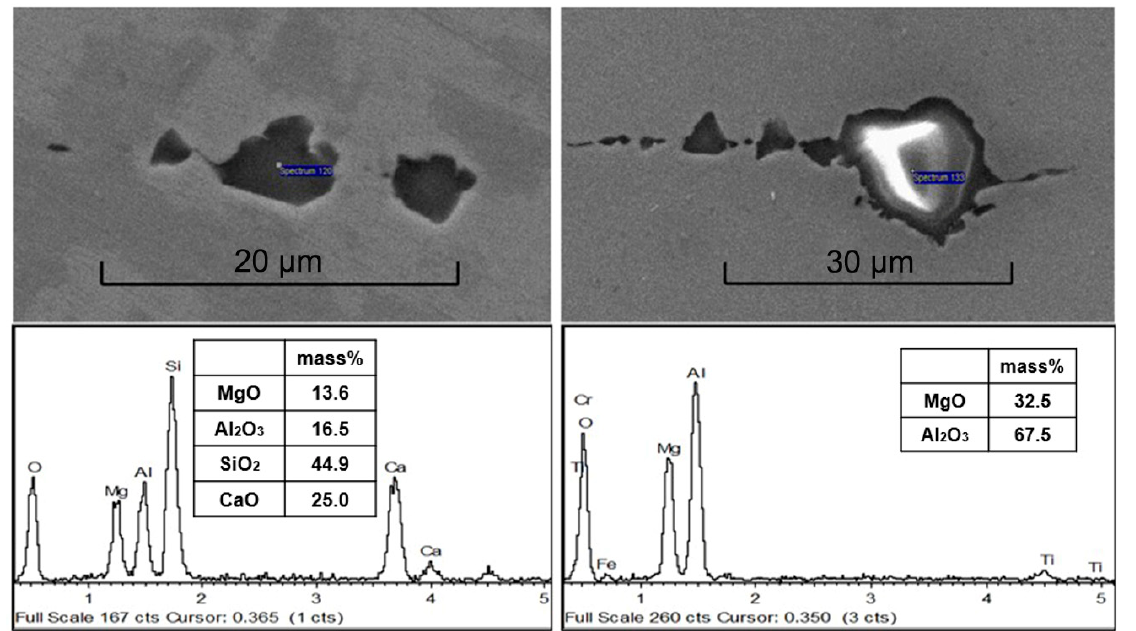
Figure 7. SEM images and EDS results of inclusions in hot rolled plates when using ordinary FeSi alloy during AOD reduction.